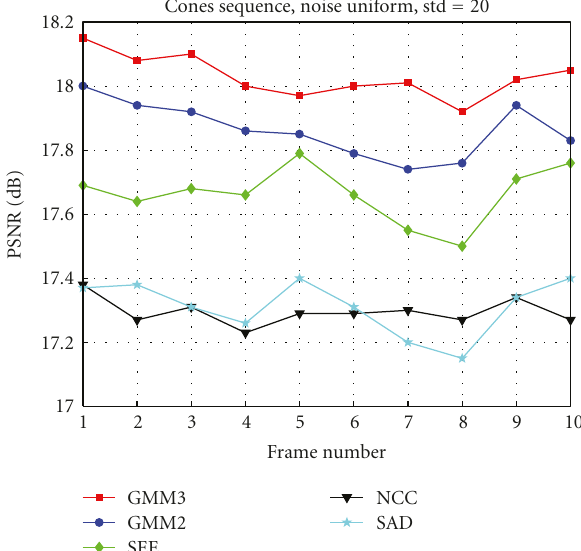
Figure 8: PSNR comparisons of SAD, SSE, NCC, GMM2, and GMM3 methods for the “Cones” sequence with influence of Uni- form noise for standard deviation equal to